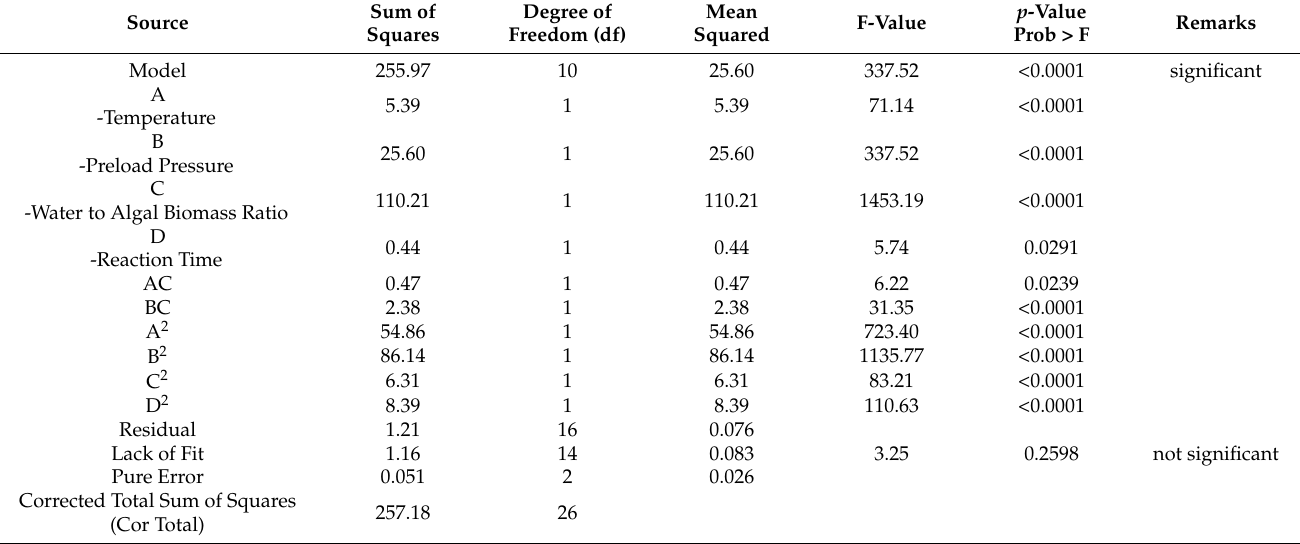
Table 6. ANOVA table for response, bio-oil